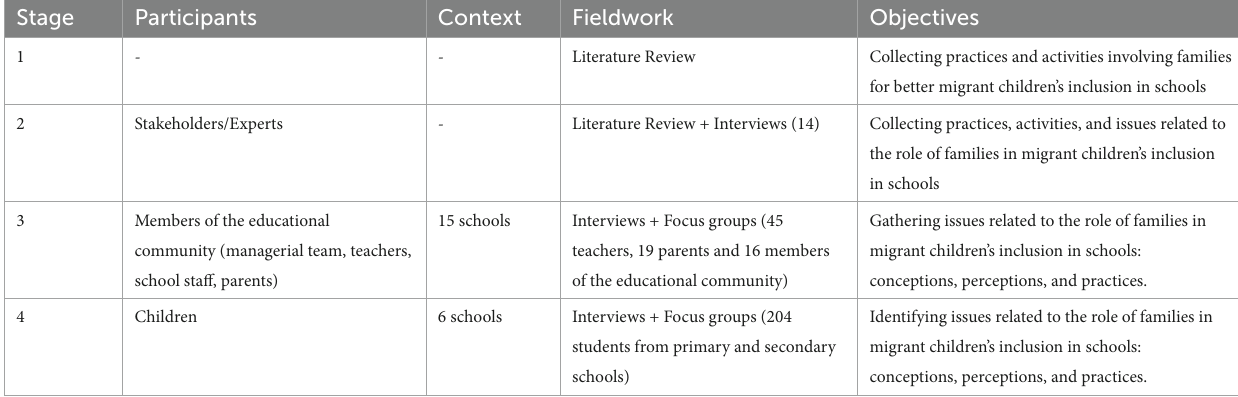
TABLE 1 Overview of the fieldwork linked to research